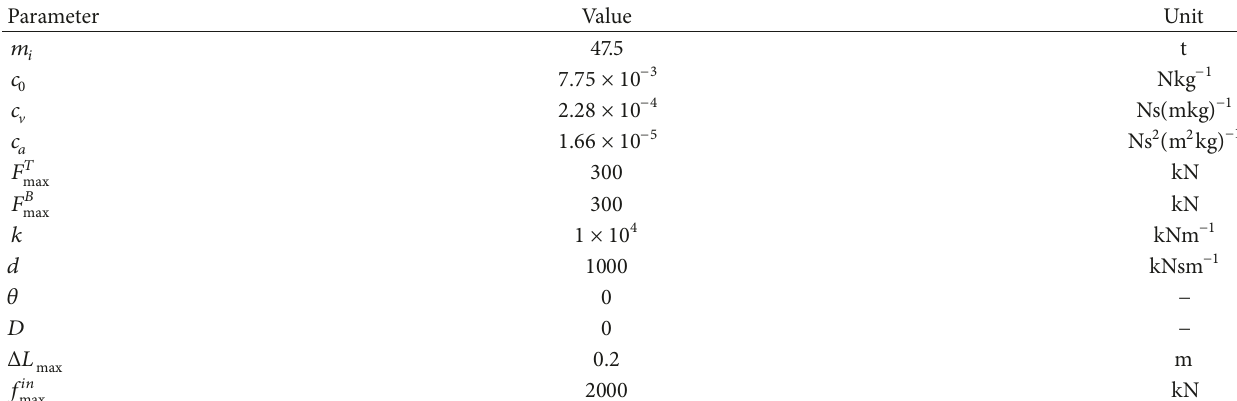
Table 5: Parameters of the CRH-3 high-speed train.